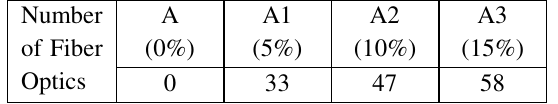
Table 3: Number of fiber optics to be embedded in each concrete block